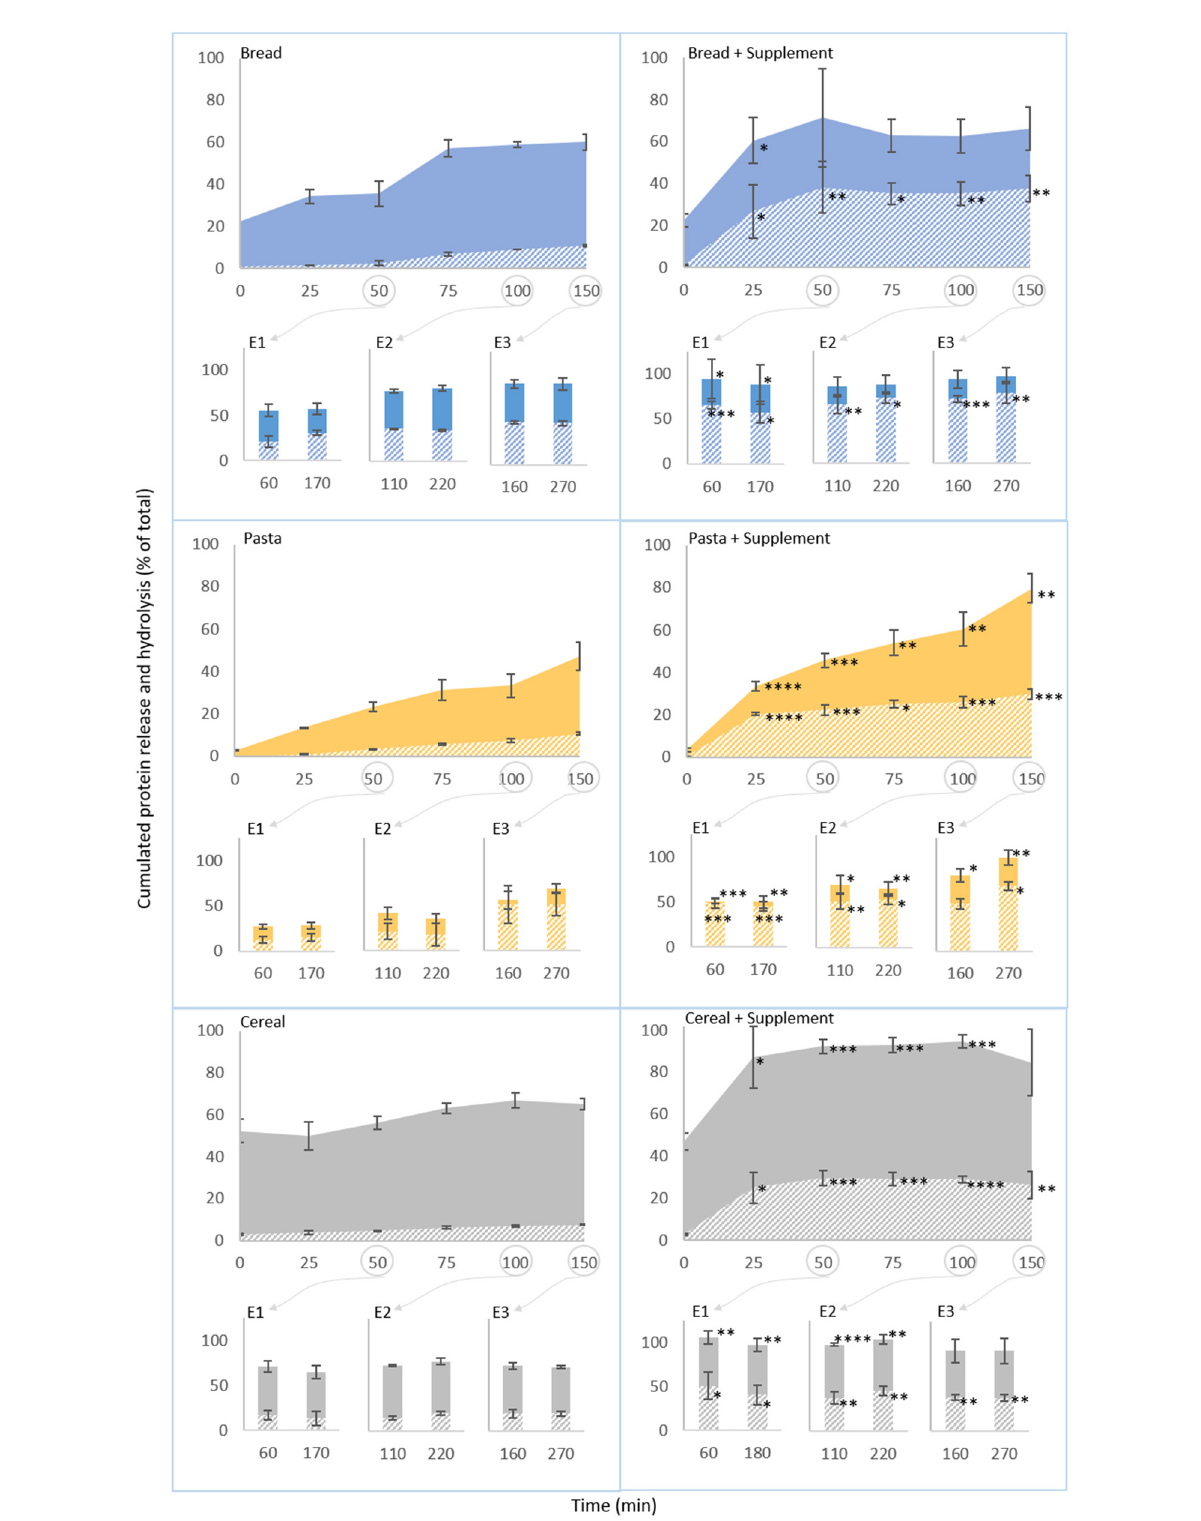
FIGURE4 Semi-dynamic in vitro digestions of bread, pasta and breakfast cereal. Proportion of initial protein (%) released (filled areas) and hydrolysed (striped areas) during the course of digestions with equal portions of food. The first point in each curve corresponds to the end of the oral phase